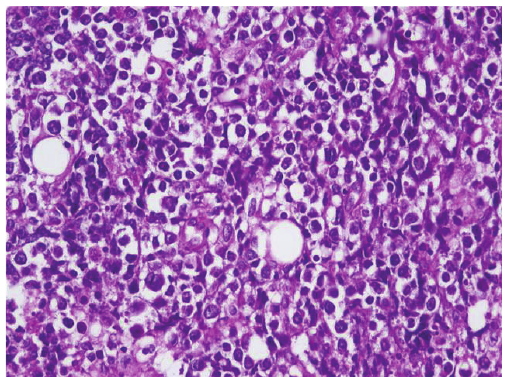
Figure 2: Seminoma infiltration that shows solid growth pattern ( × 40,